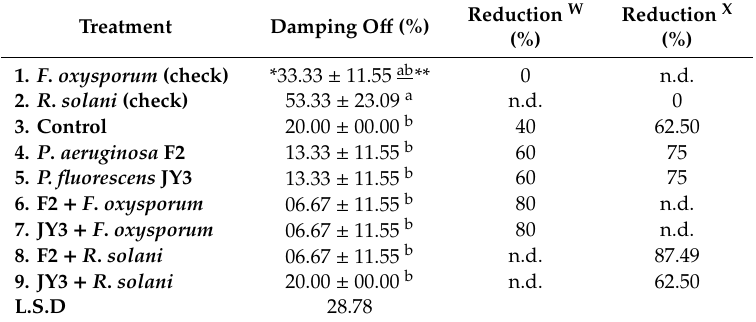
Table 3. E ff ect of culture formulations of Pseudomonas aeruginosa F2 and Pseudomonas fluorescens JY3